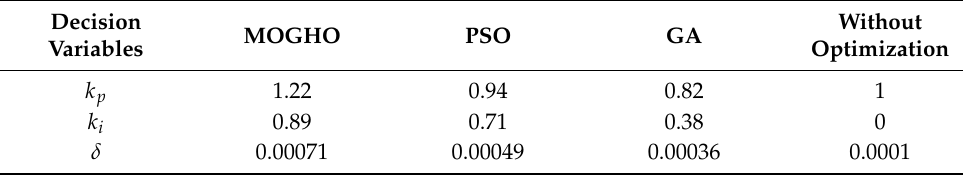
Table 2. Optimized design variables ( k p , k i and δ